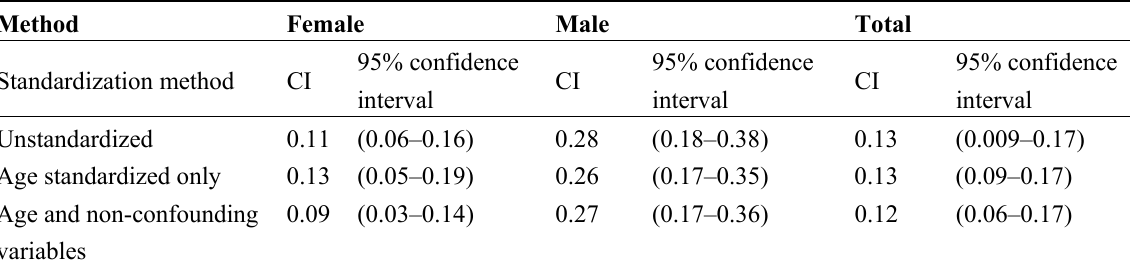
Table 2. Concentration indices of adult obesity.